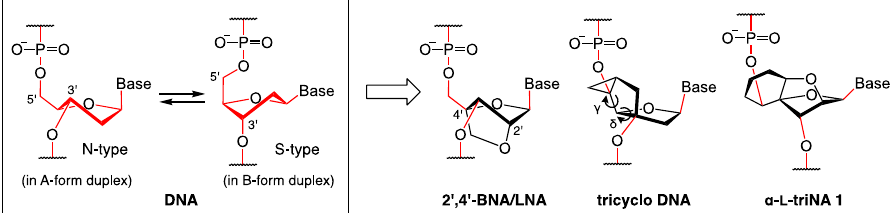
Figure 1. Conformational restrictions of natural oligonucleotides.